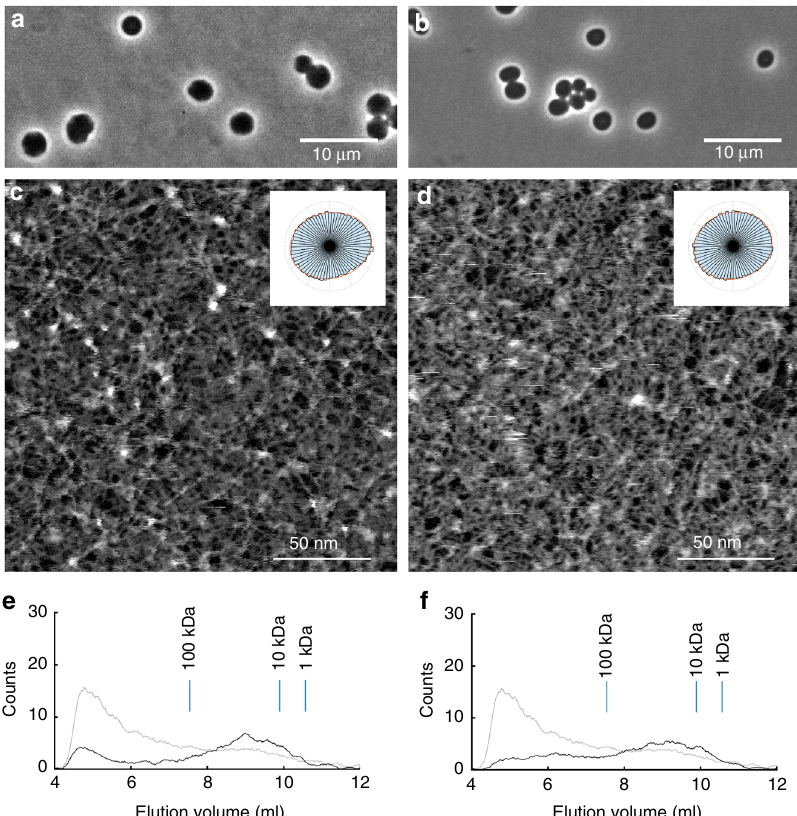
Fig. 4 Peptidoglycan characteristics in spheroid E. coli . a Optical phase contrast microscopy image of E. coli bacterial cells grown in media containing 10 μ g/ ml A22. b Optical phase contrast microscopy image of E. coli bacterial cells lacking the gene encoding MreB. c Image of peptidoglycan from E. coli grown in media containing A22, and associated polar histogram. Glycan strands appear less orientationally ordered and this is re fl ected in the more circular shape of the polar histogram. d Image of peptidoglycan from E. coli lacking the gene encoding MreB, and associated polar histogram. Glycan strands again appear less orientationally ordered. e Size exclusion chromatography trace of glycan chains from E. coli grown in media containing 10 μ g/ml A22 (black line). Chains from bacteria grown in this way are shorter than for bacteria grown in unmodi fi ed media (see trace in grey for comparison). f Size exclusion chromatography trace of glycan chains from E. coli lacking the gene encoding MreB (black line). Chains from this genetically modi fi ed bacterial strain are shorter than those of unmodi fi ed bacteria (grey